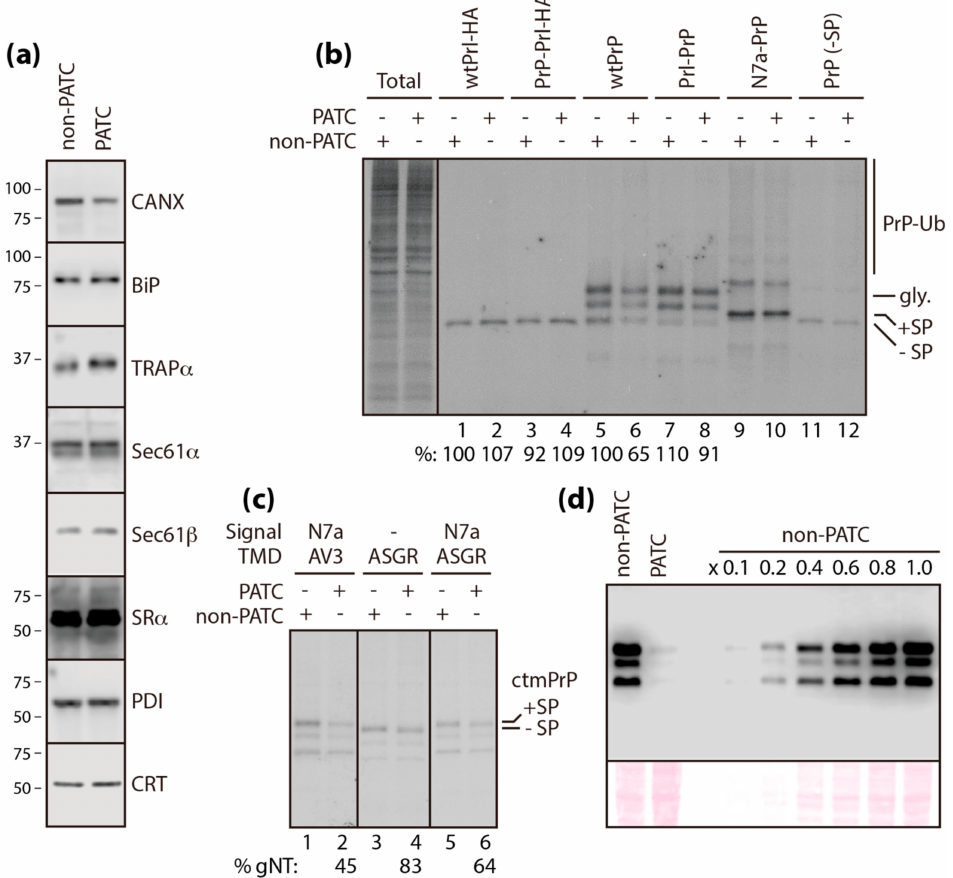
Figure 4. Analysis of PrP synthesis in PATC. ( a ) Fully solubilized non-PATC and PATC cells were subjected to immunoblotting with the indicated antibodies. ( b ) Prolactin fused with HA and newly synthesized PrP isoforms in pulse-labeled non-PATC and PATC cells transiently transfected with various mutant constructs were analyzed by immunoprecipitation with anti-HA and PrP-specific 3F4 antibodies. PrP-Ub: ubiquitinated subpopulation of cytPrP, gly: glycosylated subpopulation of PrP in the ER, + SP / -SP: uncleaved / cleaved signal sequence. ( c ) Newly synthesized ctmPrP in pulse-labeled non-PATC and PATC cells transiently transfected with the indicated constructs was analyzed by immunoprecipitation with an anti-PrP-A antibody. ( d ) The amount of ctmPrP accumulated in non-PATC and PATC cells was titrated by immunoblotting with the 3F4 antibody (upper panel). Serial dilution of protein loading was confirmed by staining the blot with Ponceaus S (lower